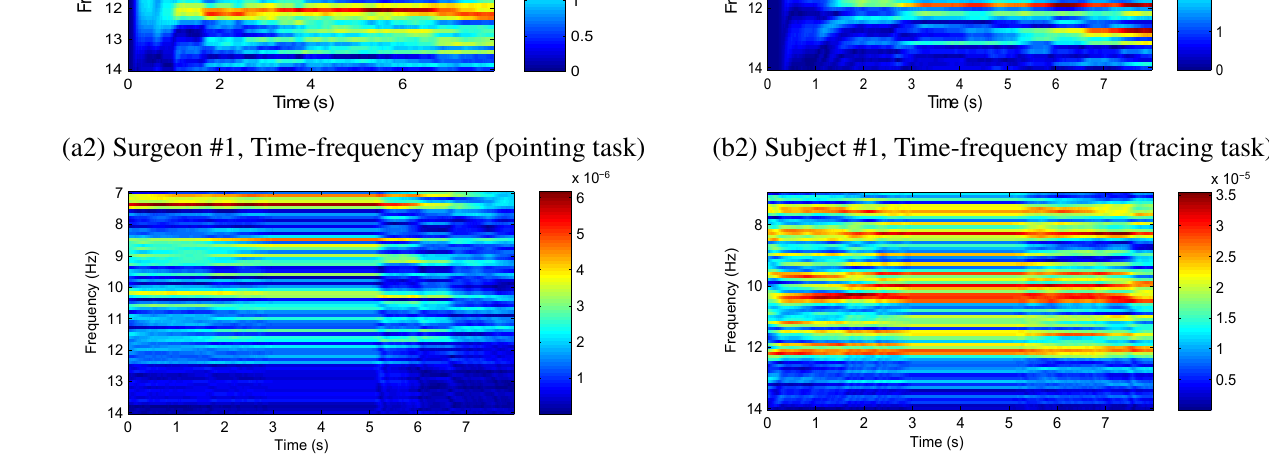
(a3) Surgeon #1, Spectrogram (pointing task) (b3) Subject #1, Spectrogram (tracing